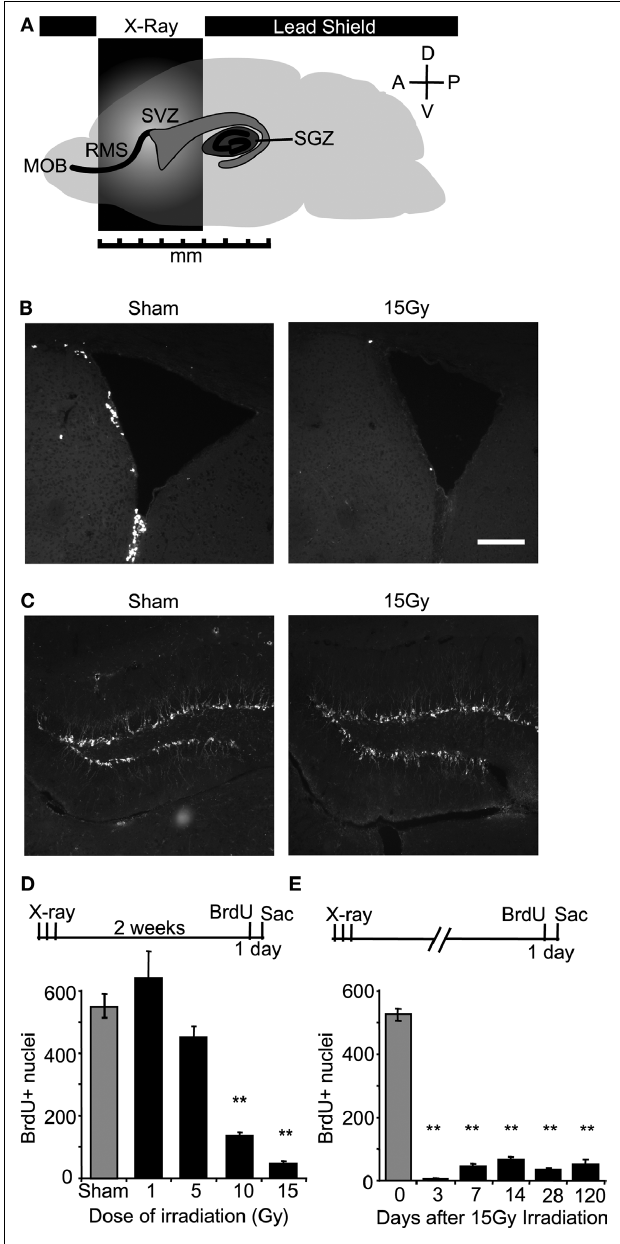
FIGURE 1 | X-ray irradiation of the sub-ventricular zone produces a long- lasting reduction in cell proliferation. (A) Schematic showing the placement of the x-ray window (5 mm A-P × 13mm M-L). (B) BrdU positive nuclei along the SVZ were mostly eliminated weeks to months following irradiation. Scale bar = 100 µm. (C) X-ray targeting did not alter proliferation in the dentate gyrus observed using doublecortin, a marker for immature migrating neuroblasts. (D) A dose-dependent reduction in SVZ proliferation was produced by controlling the exposure time during the 3-day treatment. Signifi cantly decreased proliferation relative to controls occurred at 10 and 15 Grays, and the maximally effective exposure was calculated to be 15 Grays ( n = 3 per irradiated group, n = 9 for controls). (E) A signifi cant depression in SVZ proliferation was observed up to 4 months in irradiated mice compared to age- matched controls ( n = 3–6 for irradiated groups, n = 10 for pooled controls). **indicates p < 0.001 compared to non-irradiated control (grey) unpaired t -test, error bars indicate